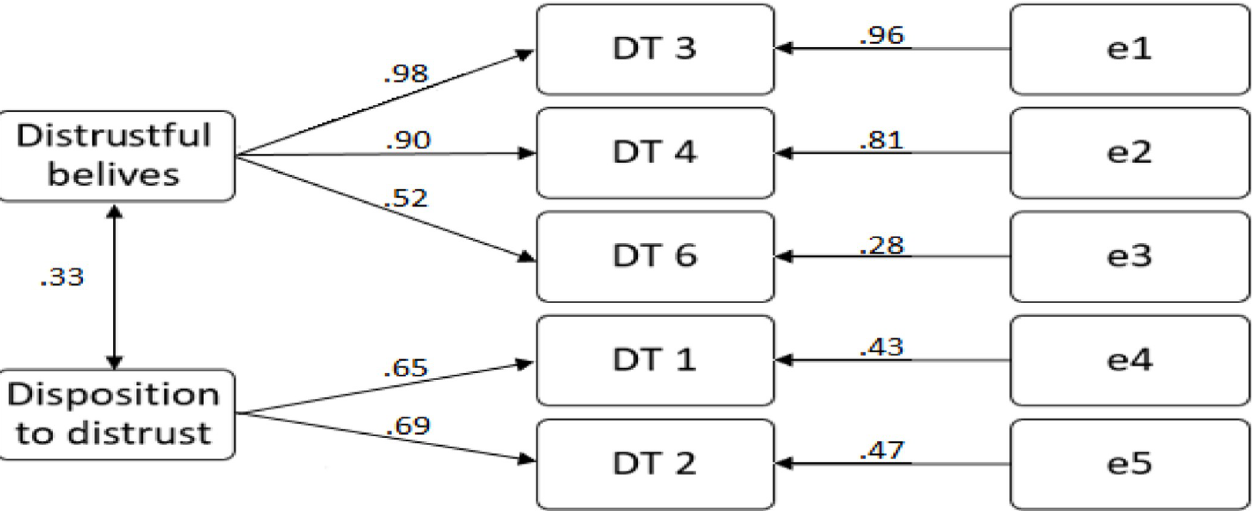
Fig 2. SEM model presenting relation between constructs of distrust. Chi-square = 23,512; df = 4; chi-square/df = 5876, p = 0.00; GFI = 0.978; AGFI = 0.916; RMSEA = 0.07; NFI = 0.973; CFI = 0.977; AIC = 45,515.